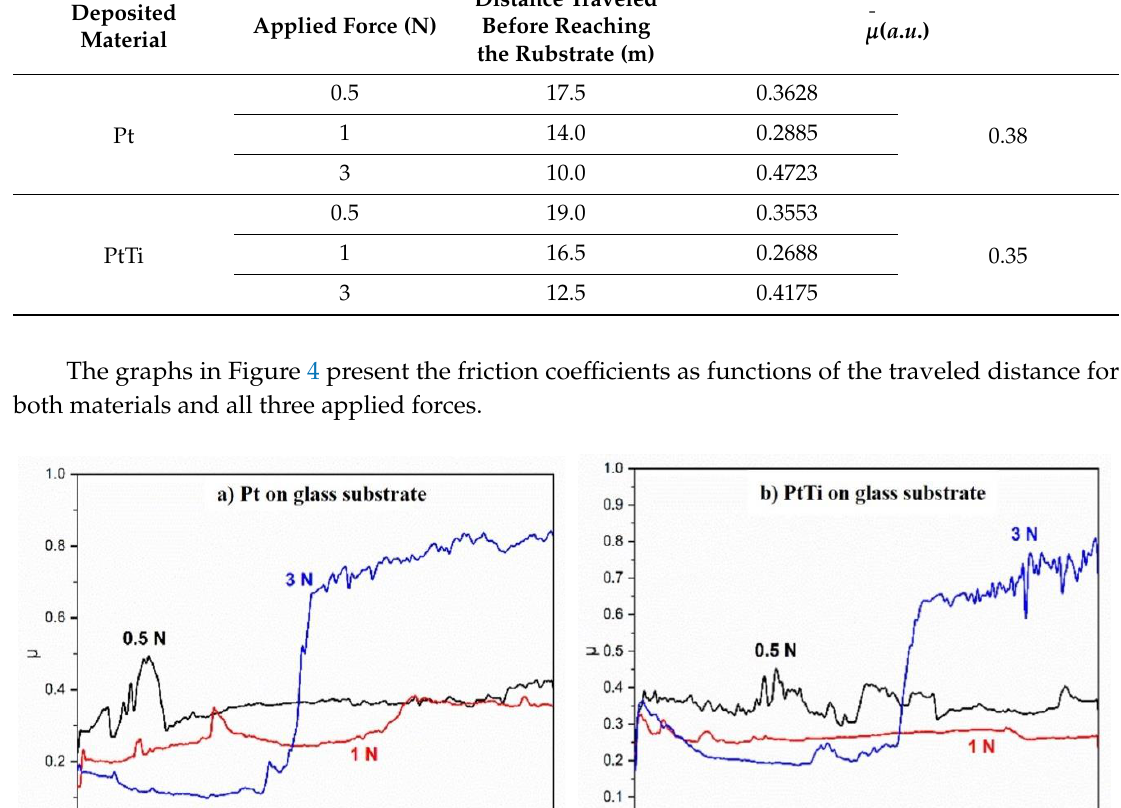
Table 3. Tribometer experimental data for Pt and PtTi thin films.